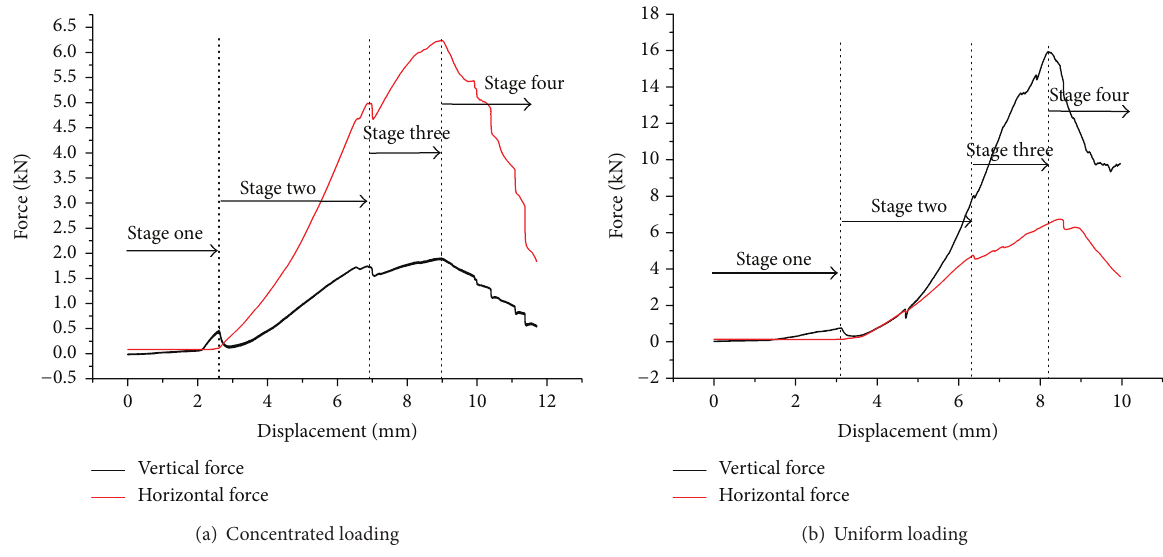
Figure 3: Force-displacement curves under different loading